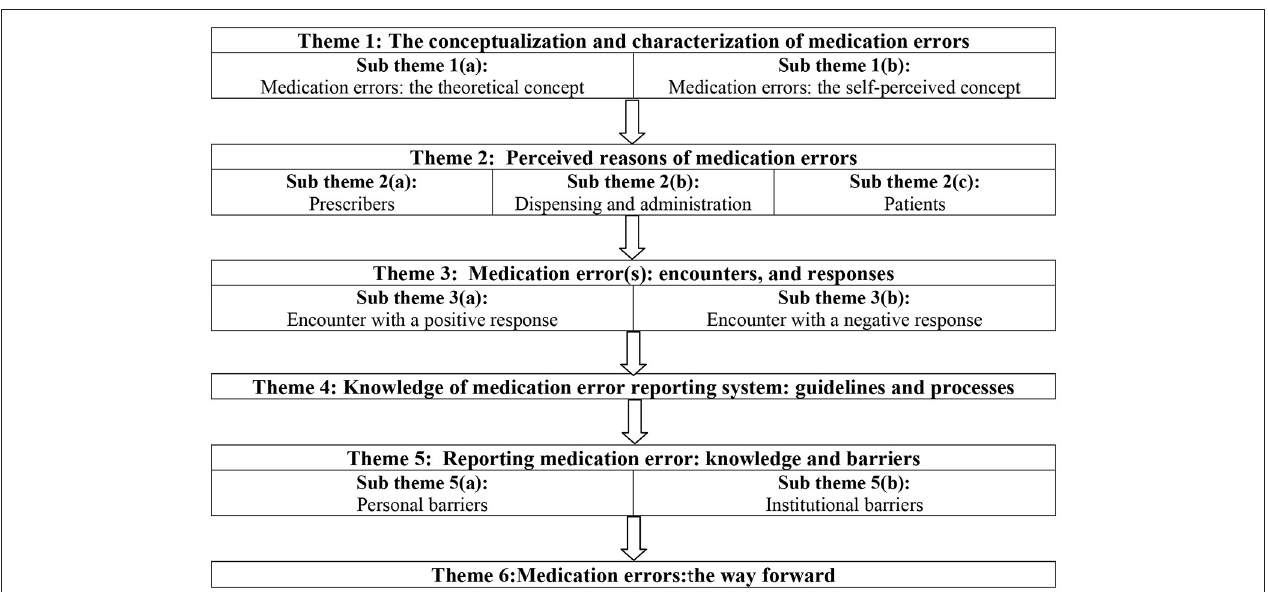
FIGURE 1 | Schematic presentation of themes and sub themes identified during data analysis.